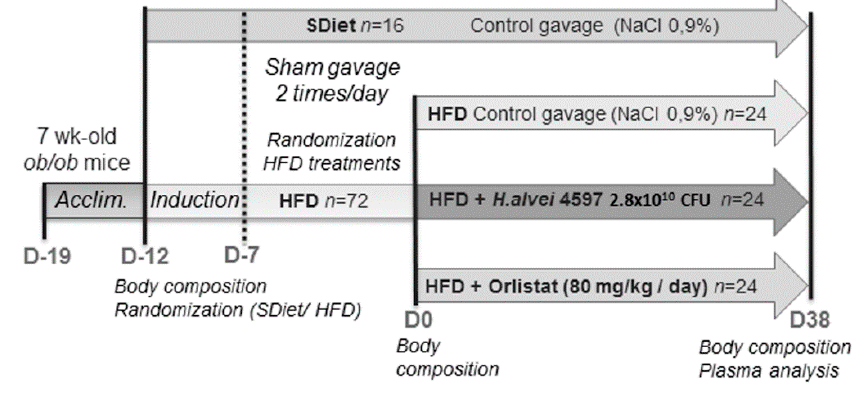
Figure 1. Experimental protocol of the study.